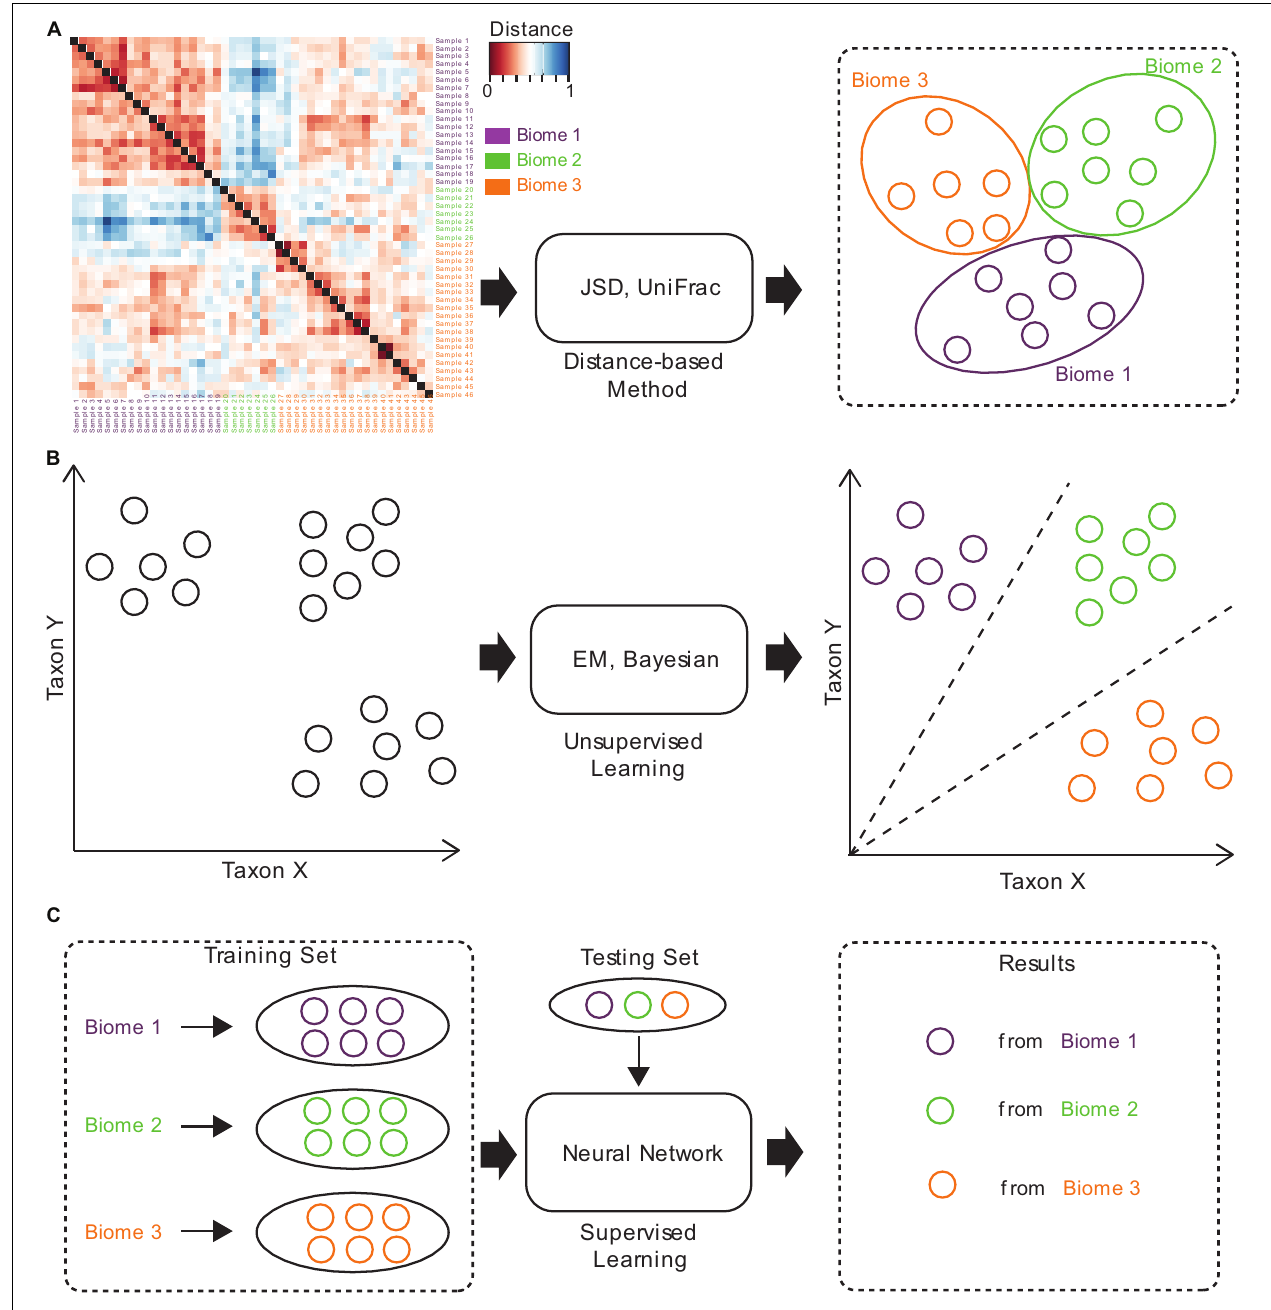
FIGURE 2 | The brief computational workflows for microbiome sample comparison and search based on (A) distance-based methods, (B) unsupervised methods, and (C) supervised methods.